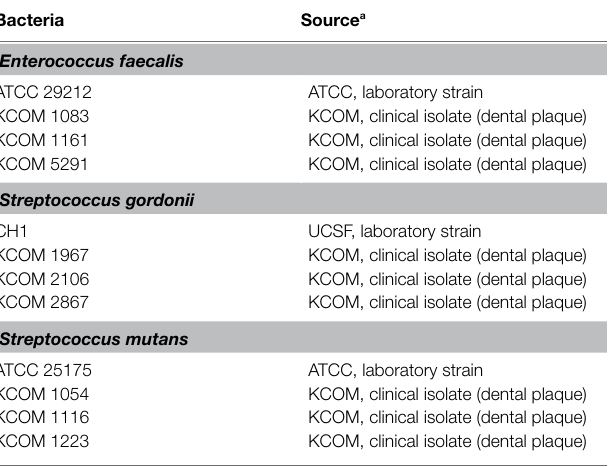
TABLE 1 | Information of dental pathogenic bacteria strains.